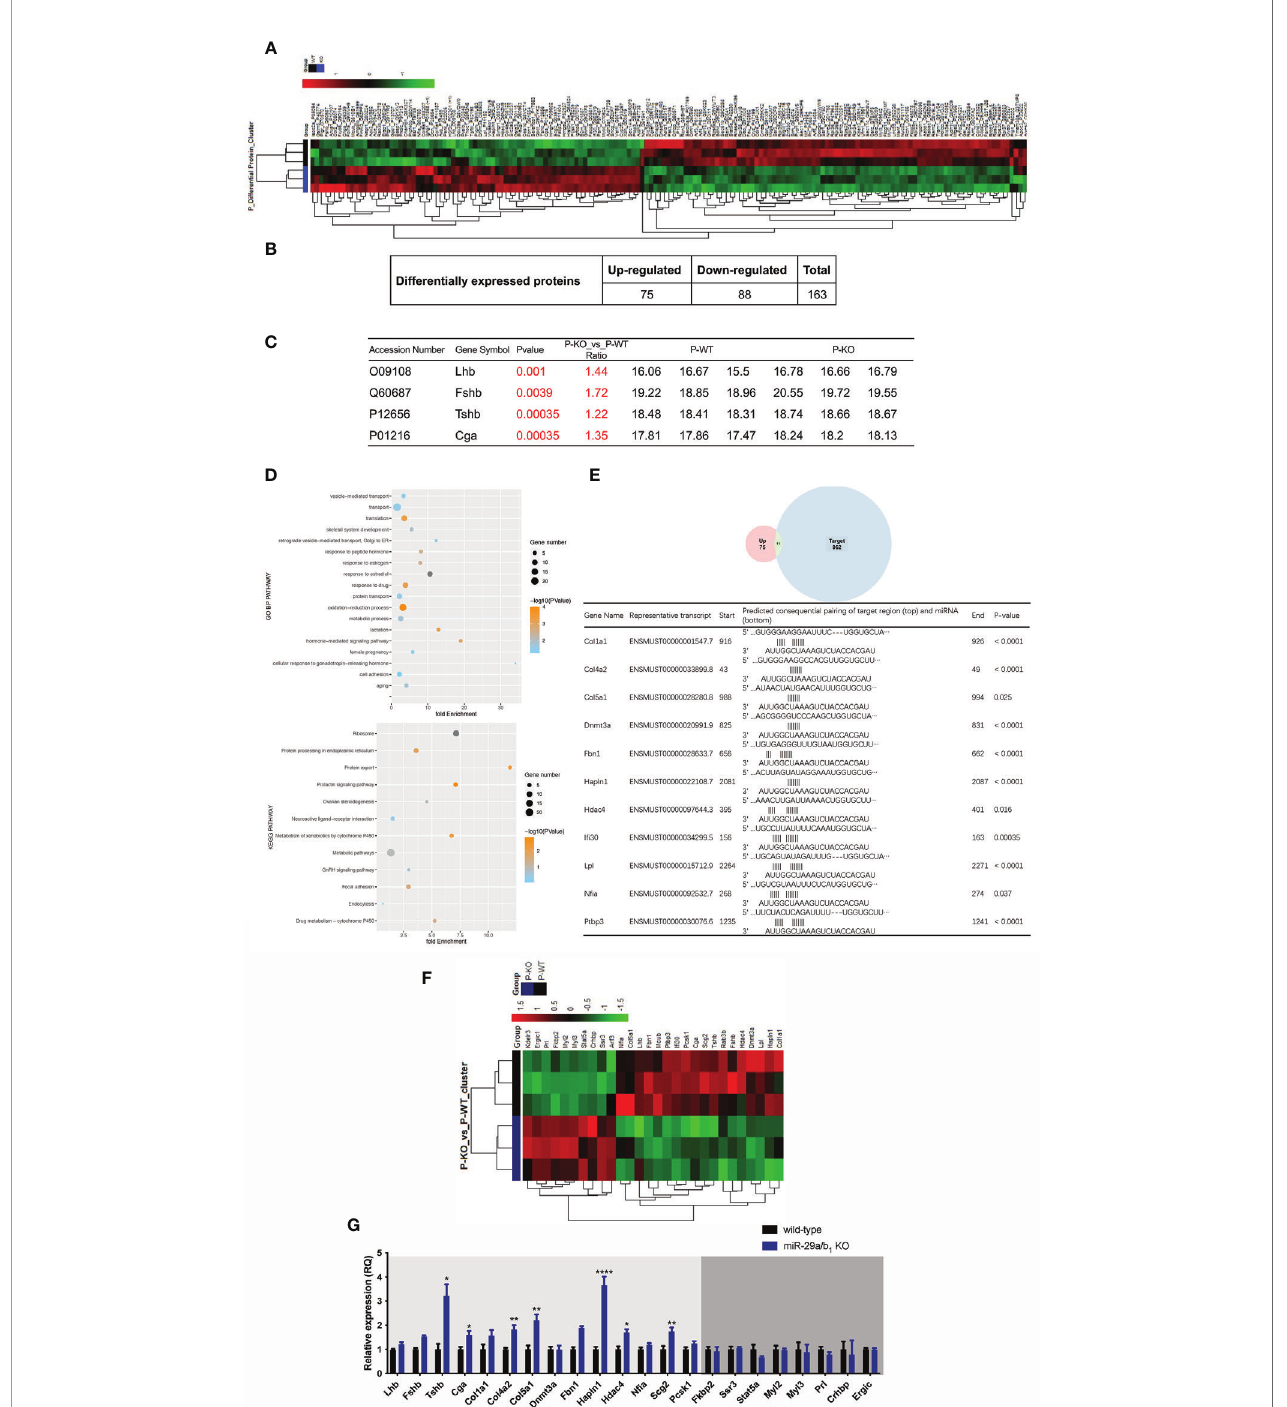
FIGURE 7 | Comparing protein expression pro fi le in the pituitary of wild-type and miR-29a/b 1 KO mice. (A, B) Differential protein from pituitary of miR-29a/b 1 KO and wild-type mice (n=3 for each) detected by MS. (C) Pituitary hormone expression. (D) GO and KEGG analysis of the pituitary from miR-29a/b 1 KO compared to wild-type mice. (E) 11predicted miR-29a targets from up-regulated proteins. (F) Heat map of genes about vesicle-transport. (G) Quanti fi cation of up-regulation genes including coded pituitary hormone (light gray shaded area) and down-regulation vesicle-transport activators (dark gray shaded area) (Lhb: p=0.2411, Fshb: p=0.0002, Tshb: p=0.0017, Cga: p=0.0117, Col1a1: p=0.1038, Col4a2: p=0.0012, Col5a1: p=0.0023, Dnmt3a: p=0.9237, Fbn1: p<0.0001, Hpln1: p<0.0001, Hdac4: p=0.0332, N fi a: p=0.1379, Scg2: p=0.0058, Pcsk1: p=0.0743, Fkbp2: p=0.6975, Ssr3: p=0.6844, Stat5a:0.1329, Myl2: p=0.7879, Myl3: p=0.7858, Prl: p=0.1706, Crhbp: p=0.7510, Ergic: p=0.7937 , n=6). * p < 0.05, ** p < 0.01 and **** p <